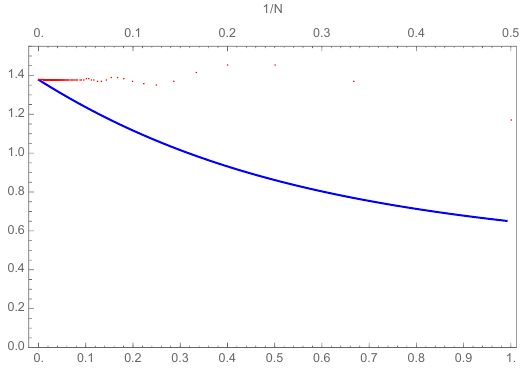
Figure 3 . A numerical check of the existence of the limit (3.11), for f ( (cid:28) ) given in the text. The curve is the integral under the limit sign, and the red dots are the partials sums of Fourier coe(cid:14)cients in the r.h.s. of (3.11) up to n = N